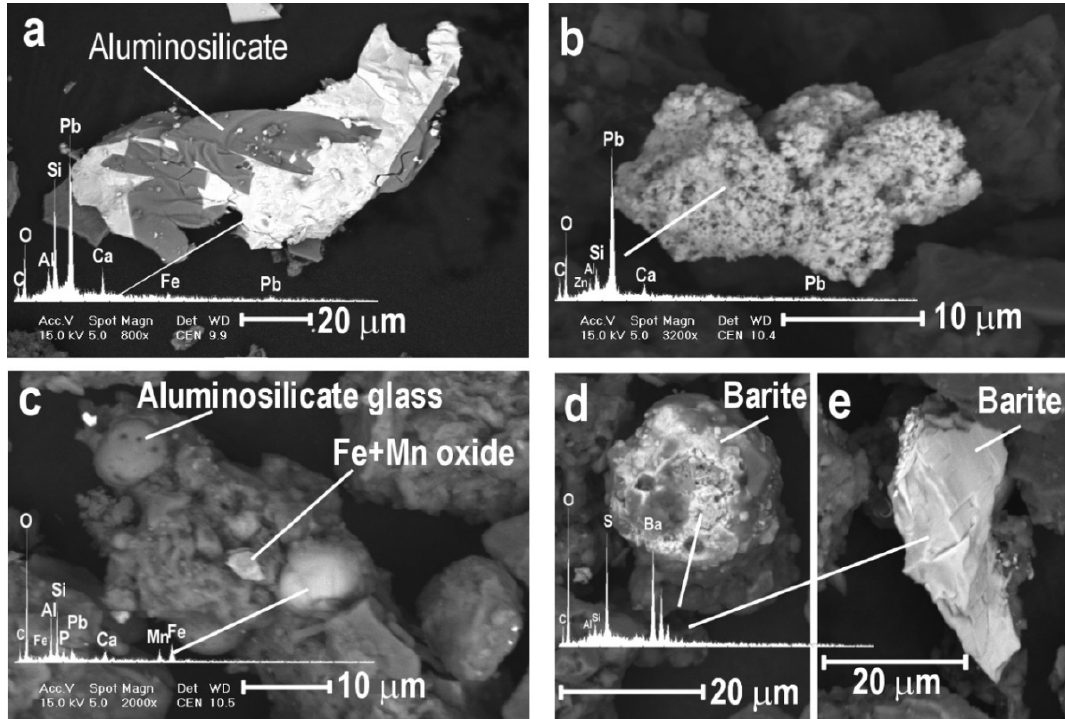
Figure 2. BSE images of metal components in the topsoil from areas of archaeological investigation of medieval Ag-Pb smelting operations. ( a ) Aggregates Pb-oxides and aluminosilicates. ( b ) Microporous grain Pb carbonate. ( c ) polymineral aggregate with Fe and Mn oxide, Pb-phosphate and Fe-Mn-oxide. ( d ) Barite transformed by melting. ( e ) Barite in crystal form.